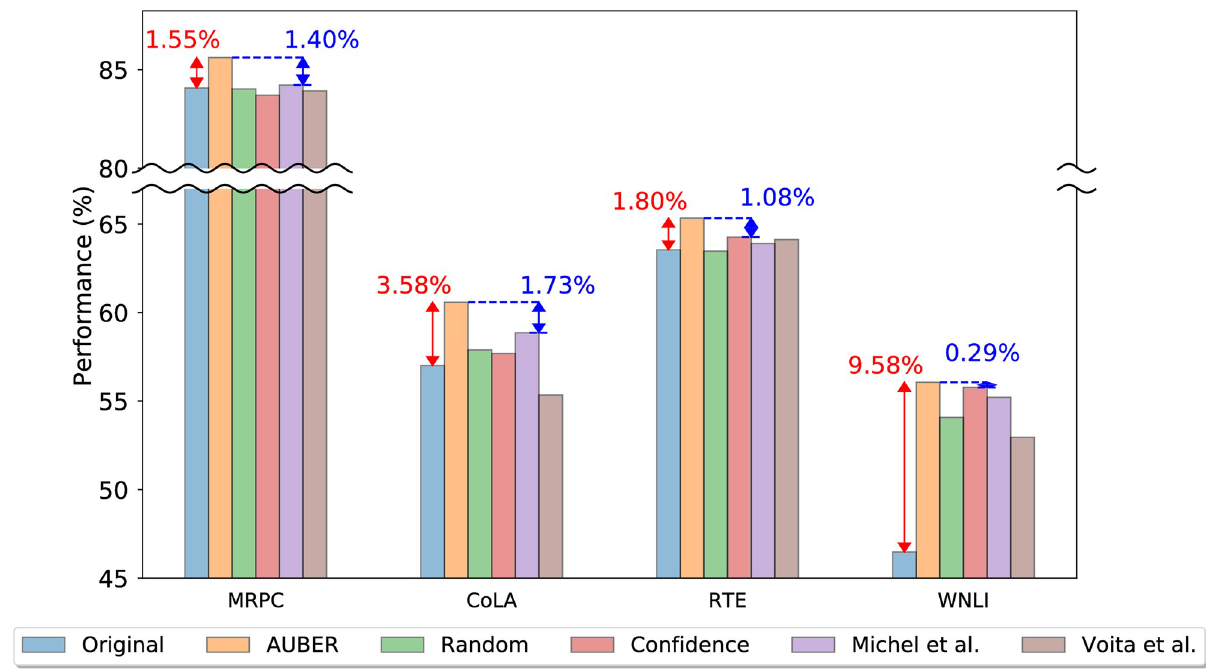
Fig 1. Performance of AUBER and its competitors on 4 GLUE datasets. AUBER successfully regularizes BERT model, enhancing the model performance up to 9.58%. AUBER provides the best performance among the state-of-the-art BERT attention head pruning methods.